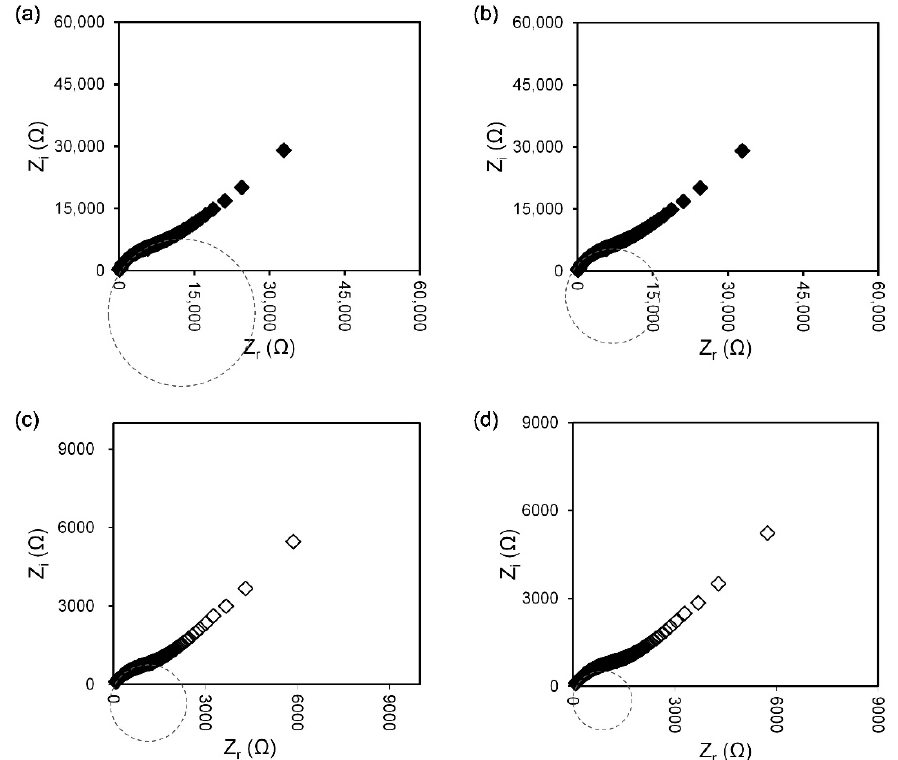
Figure 1. Nyquist plots for ( a ) AMg0, ( b ) AMg25, ( c ) AMg30, ( d ) AMg35 polymer electrolyte films.